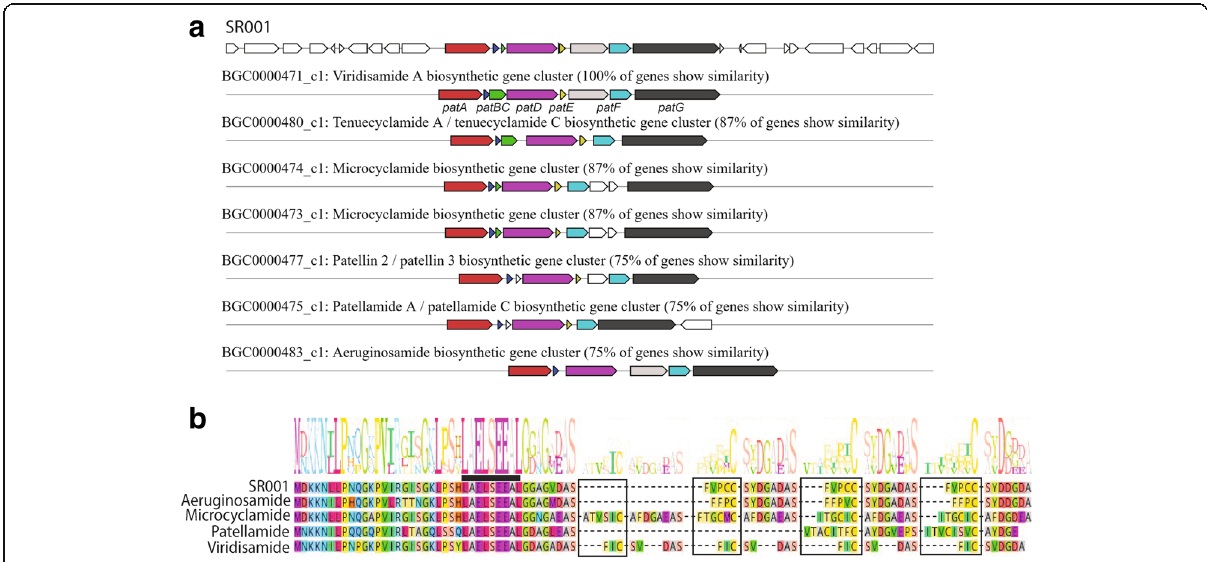
Fig. 4 a Gene cluster in the genome of strain SR001 encoding biosynthesis of a putative cyanobactin related to viridisamide A. The patABCDEFG labelled for viridisamide A was named according to Fig. 4 a [35], and their predicted functions are listed in Table 5; b Alignment of cyanobactin precursor peptide according to [35]. Conserved motif LAELSEE is underlined, whereas conserved variable regions that are cleaved to form final cyanobactin are boxed